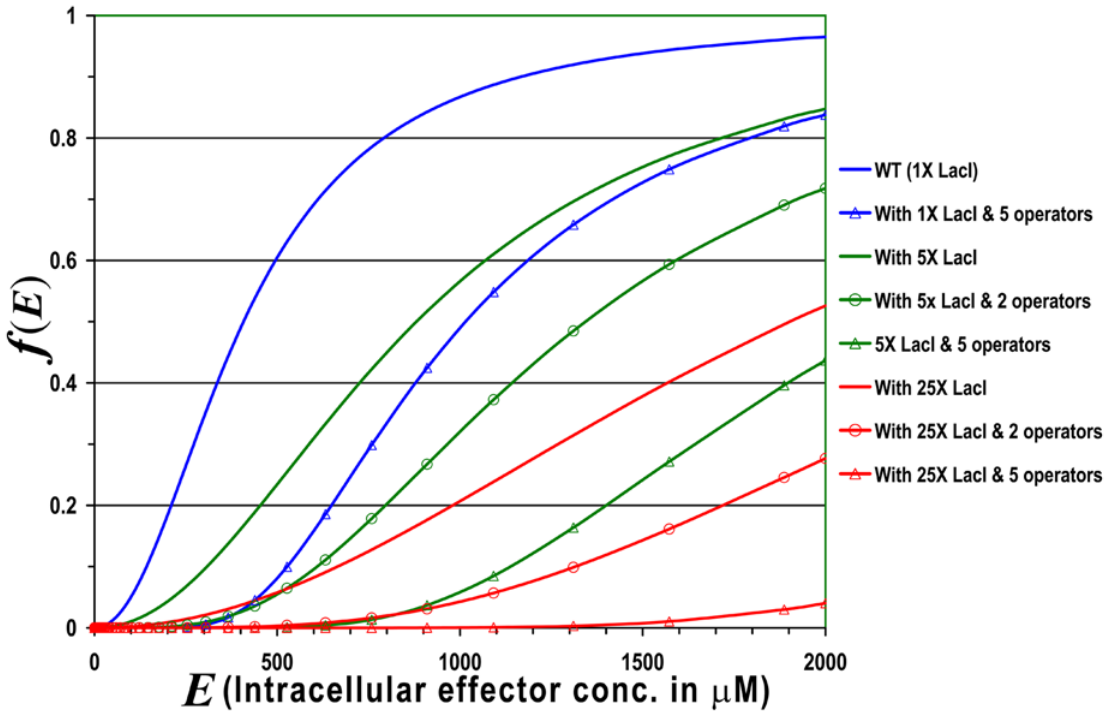
Figure 1. Number of operators vs.Lac I expression . Plot of fraction of free Lac operators as a function of effector concentration for different amounts of intracellular Lac I and different number of operators. Here 1X is considered to be the intracellular concentration of Lac I in wild type E.coli.